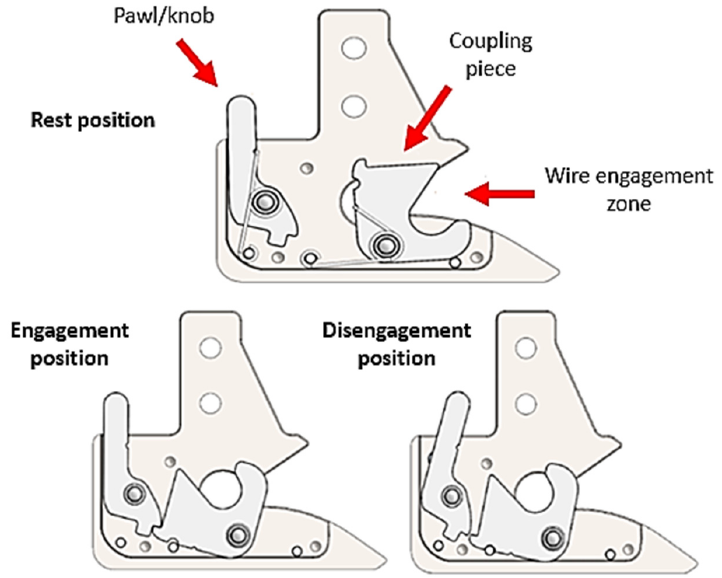
Figure 17. Working positions of the gripper mechanism.